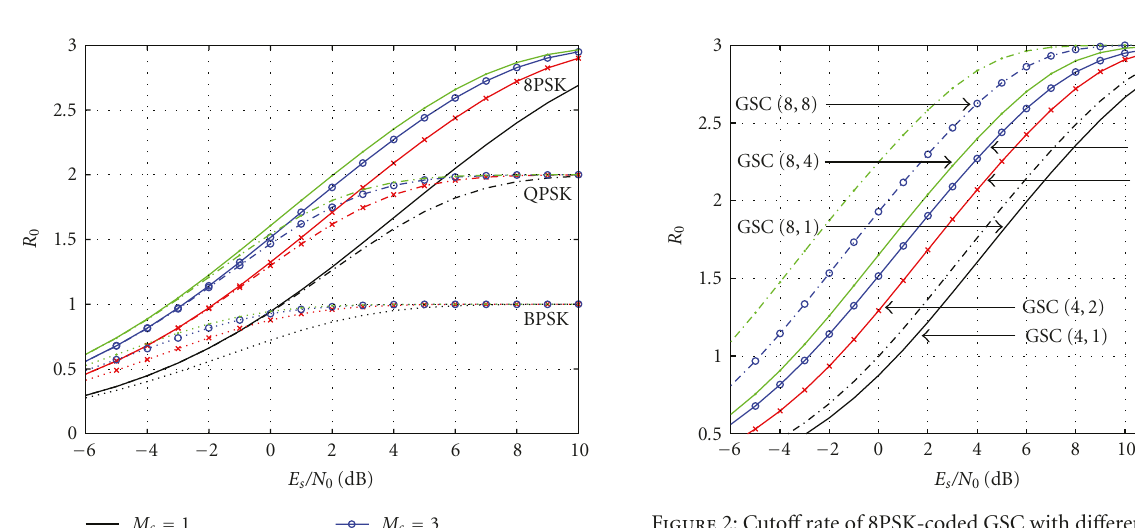
Figure 2: Cuto ff rate of 8PSK-coded GSC with di ff erent number of diversity orders in Nakagami fading with m =